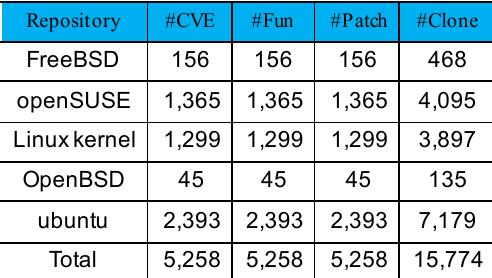
TABLE 2. Datasets used in